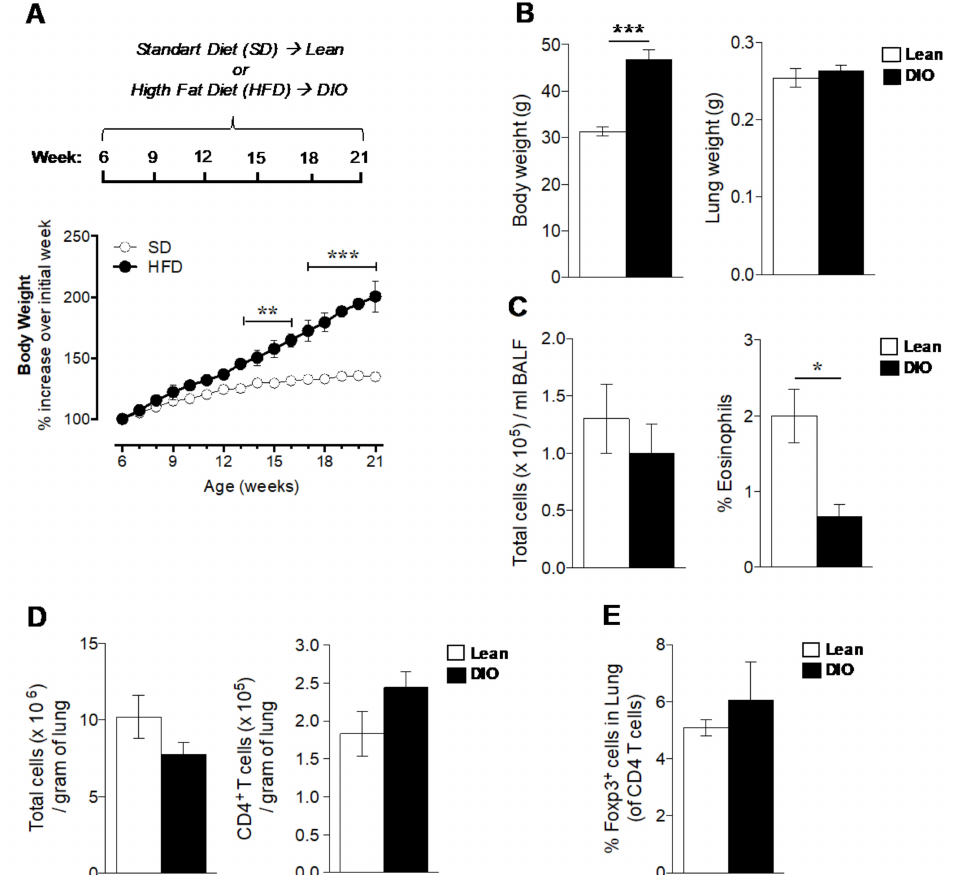
Figure 1. The e ff ect of diet-induced obesity (DIO) on lung inflammation and the expression of Foxp3 +